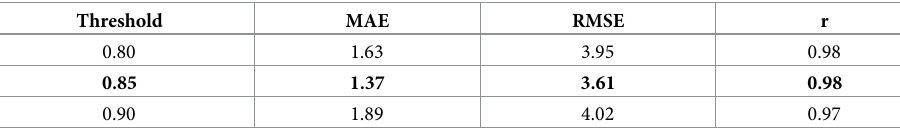
Table 2. Effect of different threshold on HR estimation